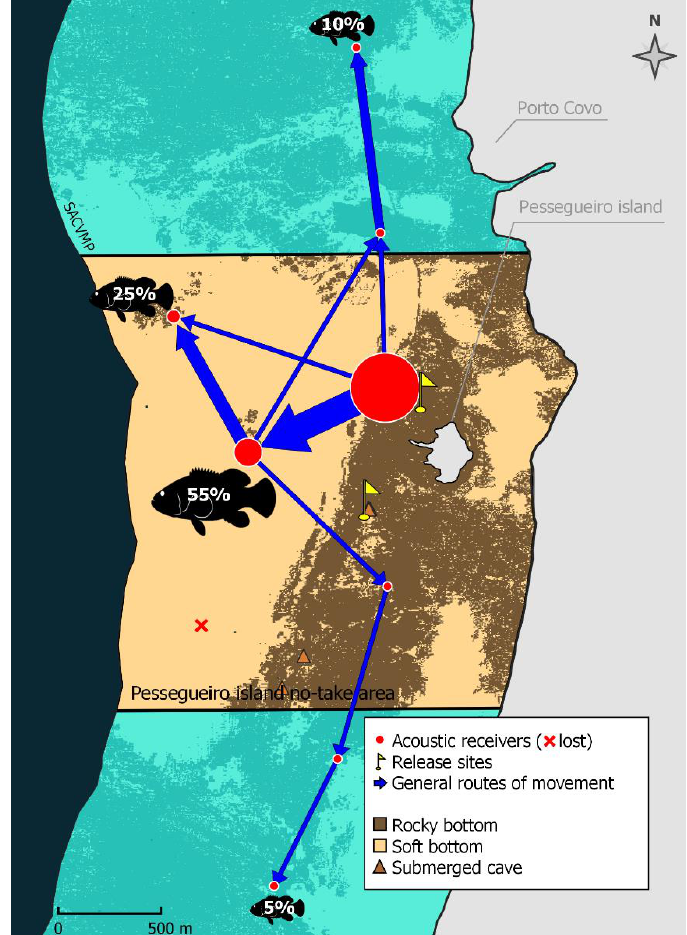
Figure 5. General routes of short-distance ranging movements of the 20 dusky groupers released in the Pessegueiro island no-take area. Nodes represent acoustic receivers, and the size of the circles is proportional to the number of detections logged in each receiver. The edge’s thickness is proportional to the number of movements between two nodes and arrows represent the direction of the predominant movement directionality. Percentages associated with the size of the dusky groupers’ silhouettes represent the proportion of individuals detected for the last time in the respective location. The light blue indicates ‘buffer areas’ of the marine park (SACVMP).